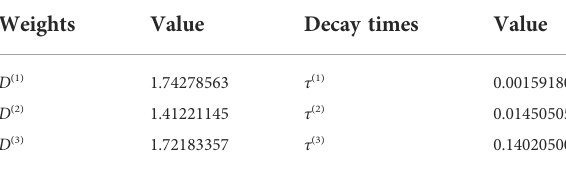
TABLE 1 The weights and decay times of three relaxation mechanisms used in the viscoacoustic